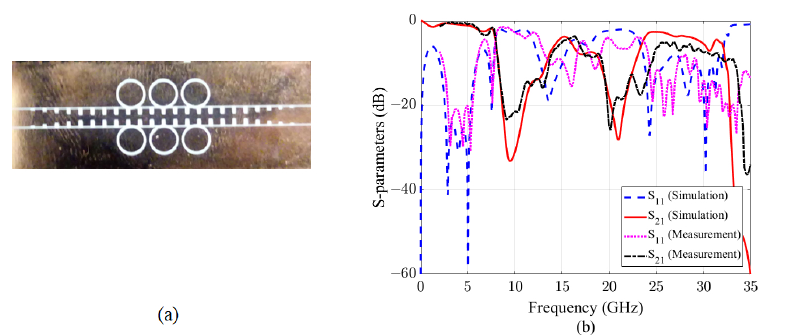
Figure 8. ( a ) Picture of the fabricated sample. ( b ) The simulation and experiment results of the